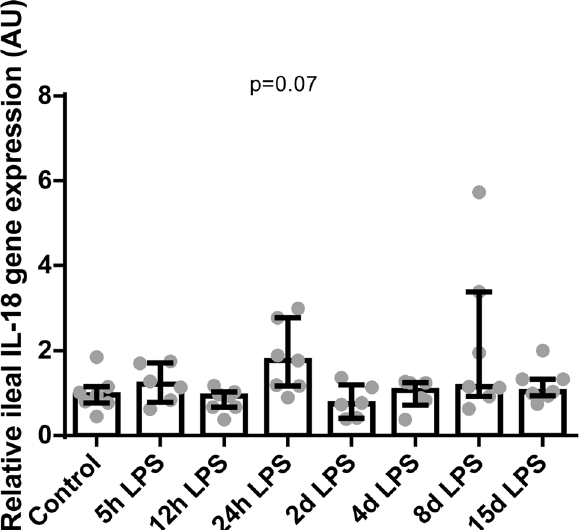
Figure 9. Relative gene expression of IL-18 in AU in the terminal ileum. Data are presented as median with IQR. IL-18 mRNA levels tended to be increased 24 hours after IA LPS administration. P = 0.07 compared to